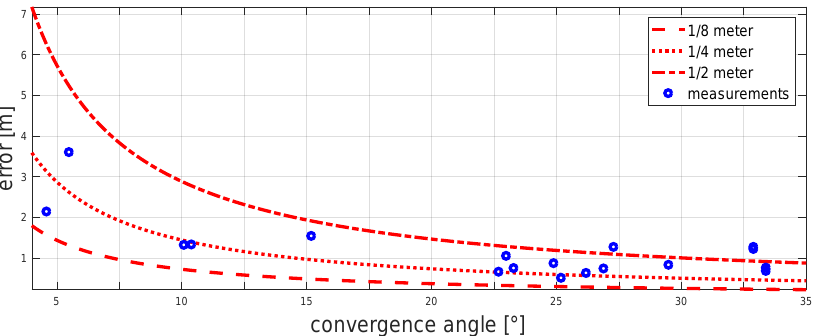
Figure 17. The 3D error is plotted versus the convergence angle, which are in the range from 4 ◦ to 35 ◦ , assuming an 2D location measurement error of 1/8, 1/4 and 1/2 m. On top of that the RMS values of the adjusted lengths (cf. Table 6) are shown in